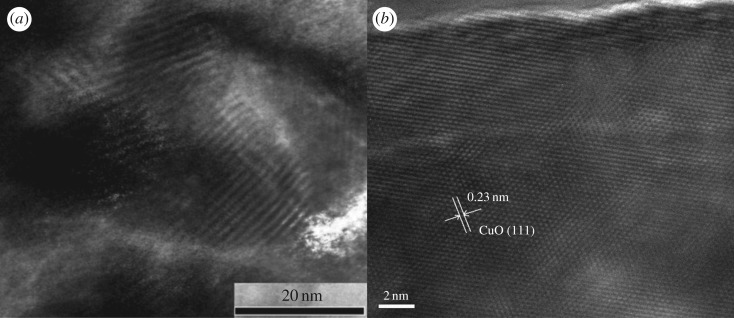
(a) TEM image and (b) HRTEM image of the 1 wt% In2O3–CuO/ZnO sample.